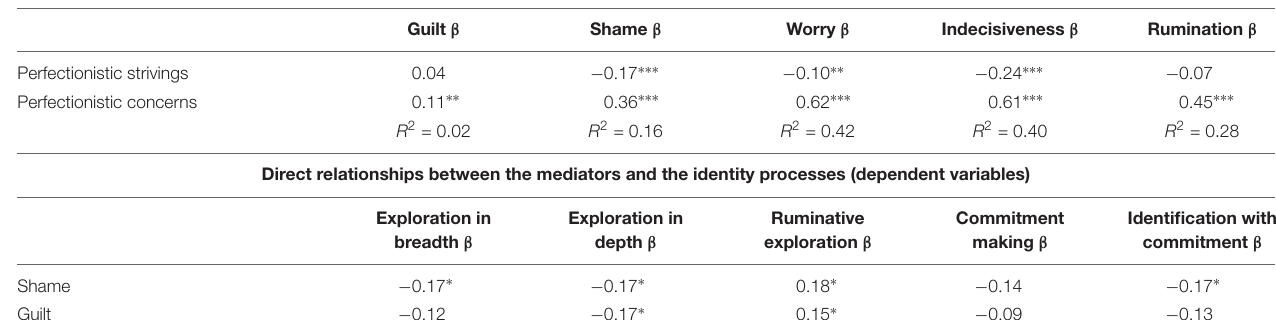
TABLE 2 | Standardized regression coefficients in the partial-mediation model (C) with the DIDS dimensions as dependent variables (the domain of the future plan). Direct relationships between perfectionism dimensions (independent variables) and